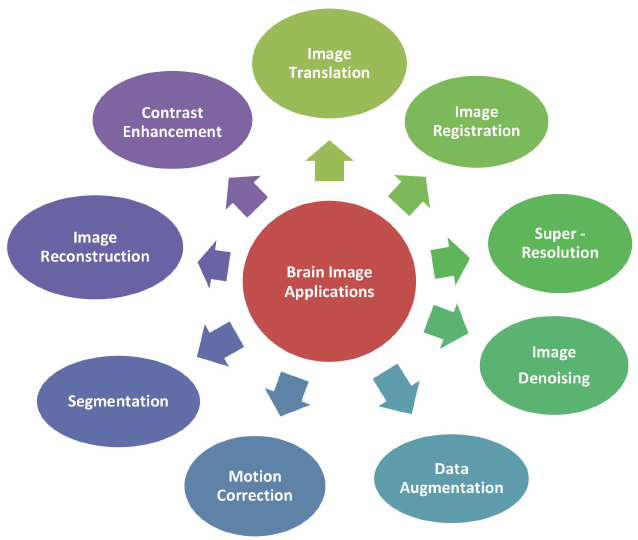
Figure 4. Applications of GAN-synthesized images for brain